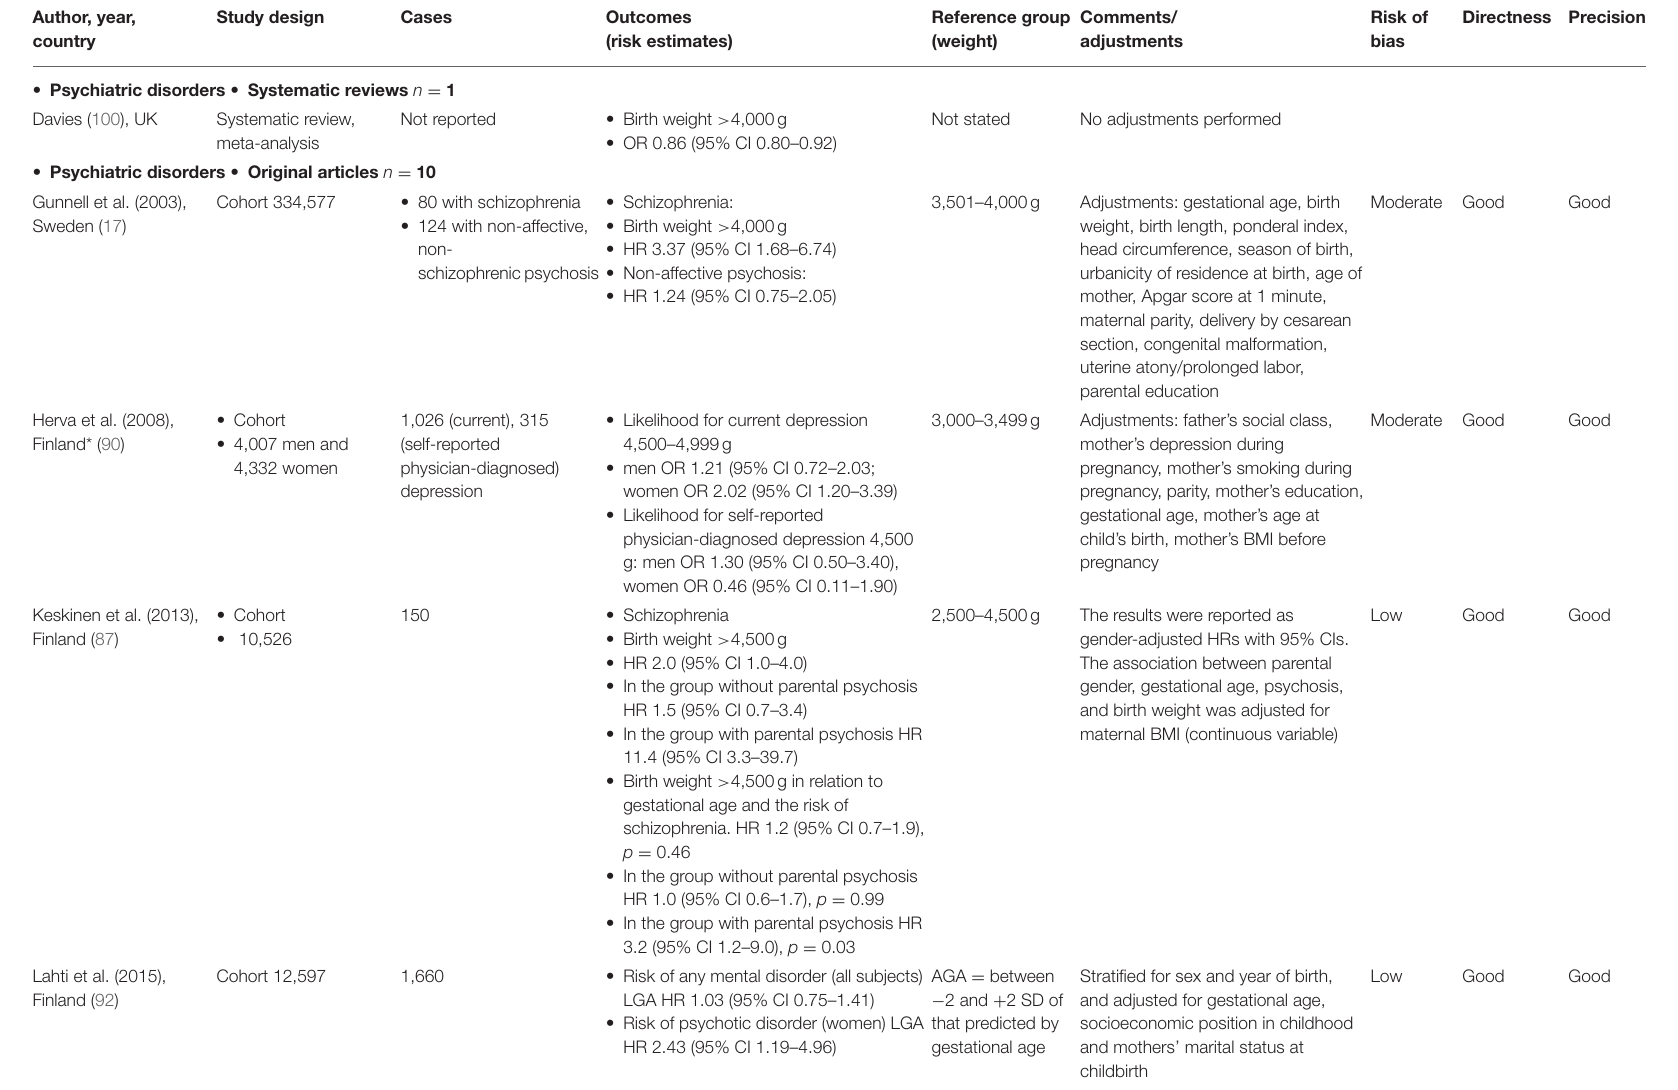
TABLE 1.2a | LGA, high birth weight, and long-term outcomes—psychiatric